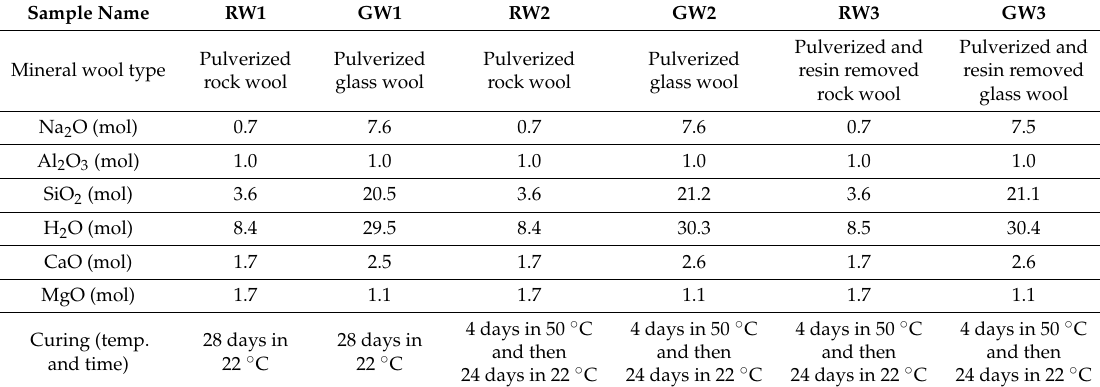
Table 3. The sample name, binder molar ratio composition, and curing temperature and time.